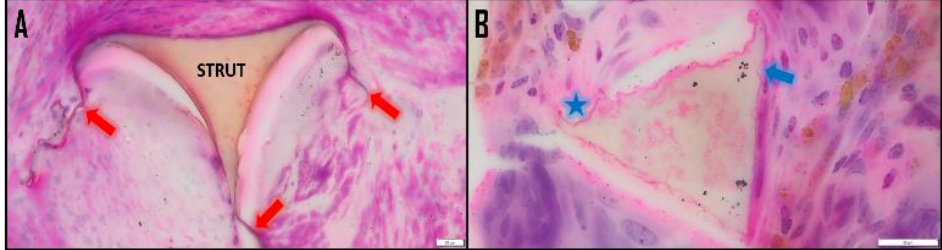
Figure 1. ( A ) The cross section of the foam strut is clearly visible in hematoxylin and eosin (H&E)- stained histology sections. Membranes are attached at the vertices of the strut (10 μm) . ( B ) Quanti- fiable degradation regions are visible along the strut, including a clear scalloping pattern (star) and lone bites (arrow) (20 μm) . These are sections of PED devices. Through spectroscopic and SEM analysis of explanted foams, Weems et al. also iden- tified elements of the degradation process (i.e., membrane loss and surface pitting along struts) that support the observed degradation profiles [2]. Previously, estimations of in vivo degradation from PED and NED devices were reported in two separate publications, employing the method outlined in this paper [6,20]. This method has since been refined and validated through theoretical investigations. This paper will outline the methodology developed for quantifying and analyzing in vivo degradation for SMP foams, specifically focusing on studies from embolic applications. The method itself contends with complex microstructures (i.e., struts and membranes), variable foam compositions and device